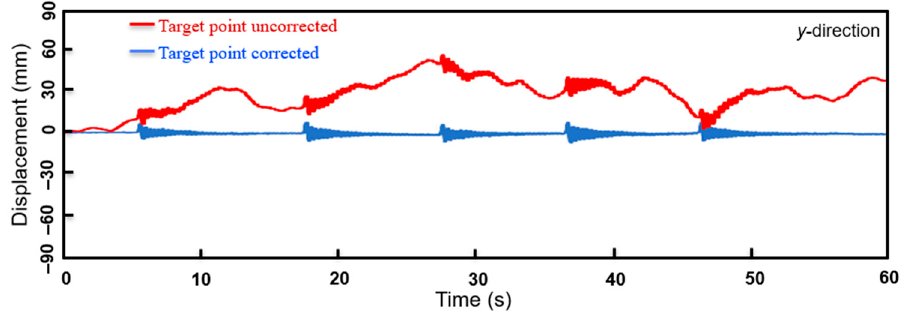
Figure 12. Displacement of the target point before and after correction.